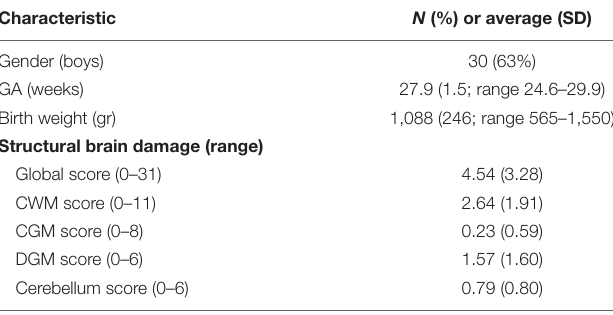
TABLE 1 | Participant